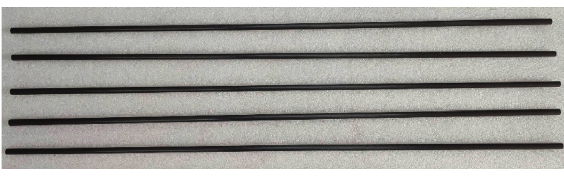
Figure 7: CFRP plain rods used.